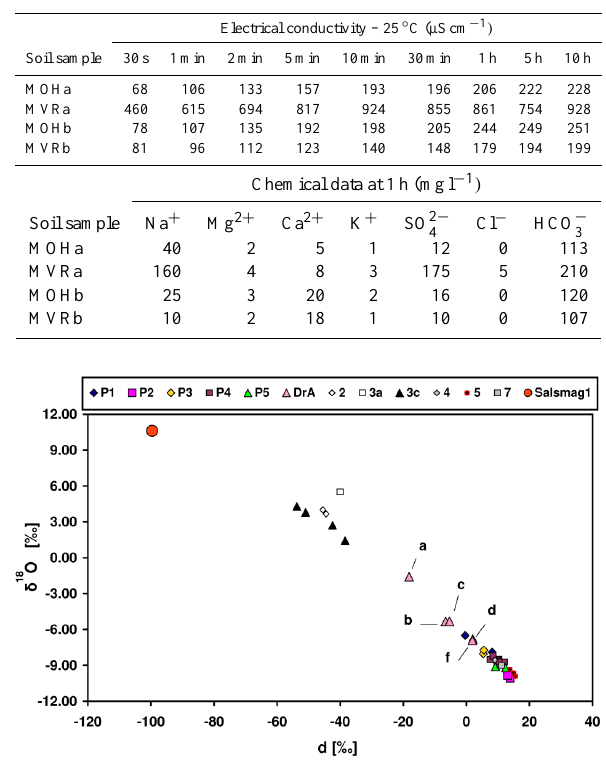
Fig. 7. d - δ 18 O diagram. DrA point sampling campaigns are re- ported. Point: 2, 4 (Boschetti et al., 2010) – baths; 3a (Conti et al., 2000), 3c (Capozzi and Picotti, 2010) – mud volcanoes; 7 (Ven- turelli et al., 2003) – spring; SalsMag1 (Boschetti et al., 2010) – oil